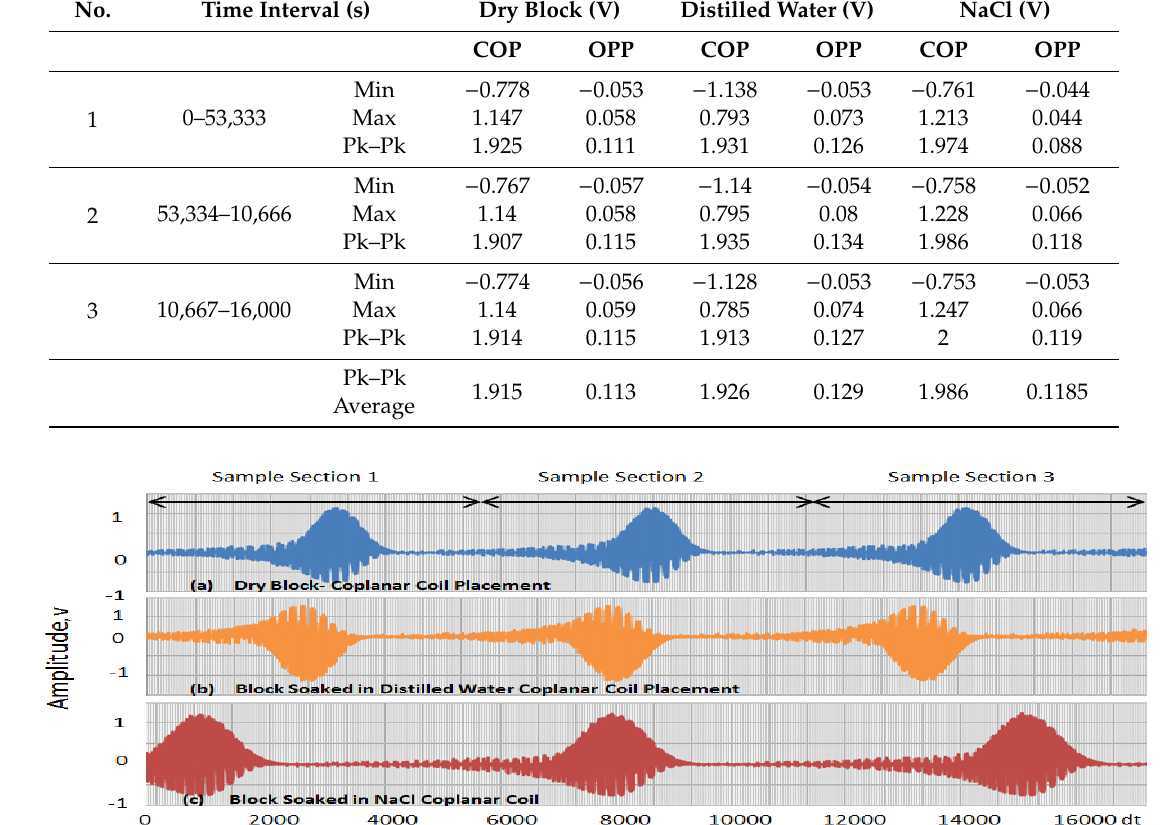
Figure 7. Voltages obtained from tests conducted with coils placed on opposite sides on ( a ) dry concrete block, ( b ) concrete block soaked in distilled water and ( c ) concrete block soaked in NaCl solution . 5.2. Coil Placed on Opposite Surfaces For the coplanar-placed sensors, the difference in the time delays between the pulses for the dry concrete block and the concrete block soaked in distilled water was approximately 0.25 s (50392.5 × 10 − 4 to 47934.5 × 10 − 4 s from Table 2), with the latter showing less delay than the former,